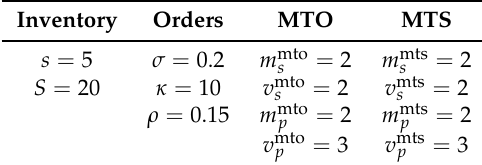
Table 1. Parameters for the base case used in the numerical examples.